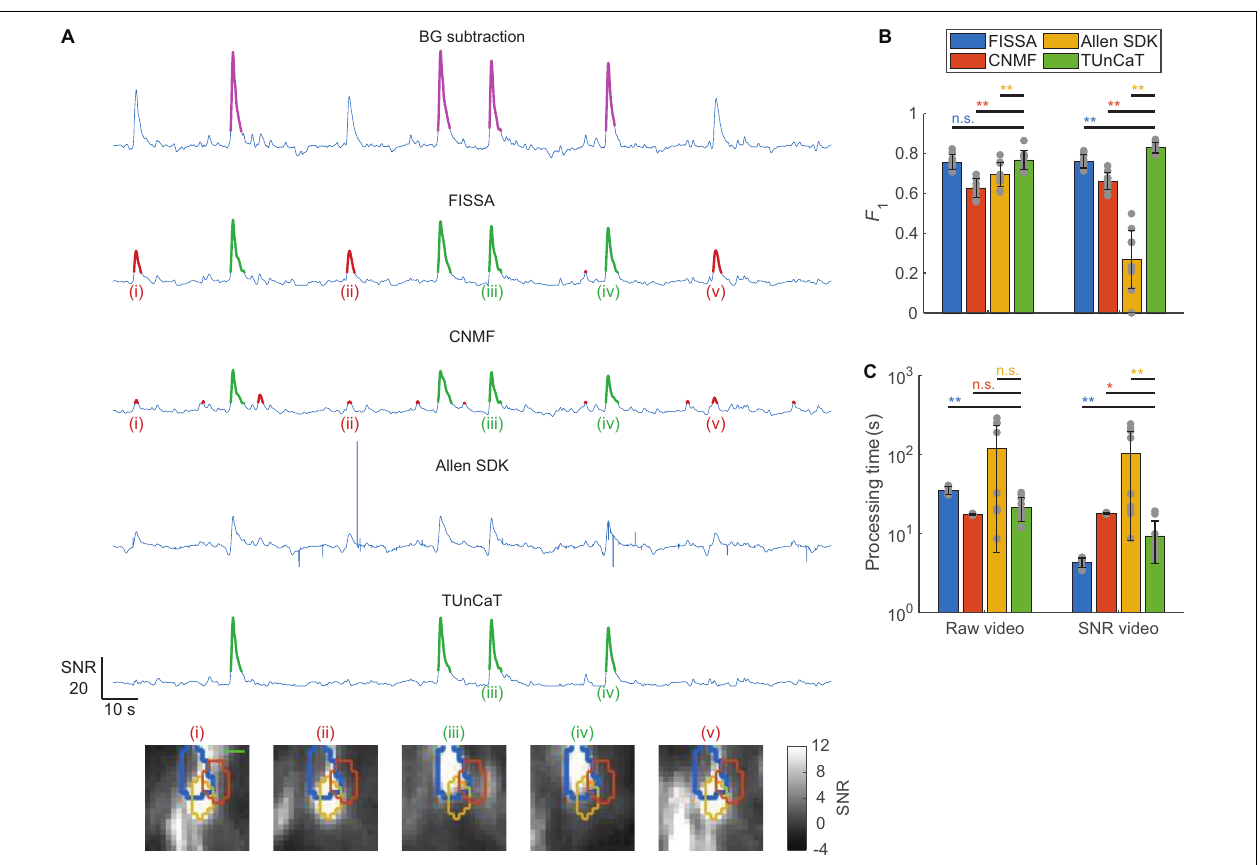
FIGURE 5 | Temporal unmixing of calcium traces (TUnCaT) was more accurate than peer algorithms when processing experimental one-photon videos. (A) TUnCaT can remove false transients caused by neighboring neurons. The first trace is the background-subtracted trace of the SNR video of an example neuron representing the trace before unmixing, and the magenta transients show the manually determined ground truth transients. The four remaining traces are the unmixed traces of that neuron from four different methods (FISSA, CNMF, the Allen SDK, and TUnCaT). The labels (i)–(v) indicate example transients correctly (green) or incorrectly (red) detected by at least one unmixing algorithm. Each image below the traces is the corresponding SNR image at the peak of each transient. The thick blue contour in each image shows the boundary of the neuron of interest, and the orange and yellow contours show the boundary of two different neighboring neurons (scale bar: 10 µ m). (B) The F 1 scores of TUnCaT during 9-round cross-validation were superior to that of the other methods both when processing raw videos and when processing SNR videos (** p < 0.005, n.s. - not significant, two-sided Wilcoxon signed-rank test, n = 9 videos; error bars are standard deviations). The gray dots represent scores for the test data on each round of cross-validation. (C) The processing time of TUnCaT was comparable to or faster than the other methods both when processing raw videos and when processing SNR videos (* p < 0.05, ** p < 0.005, n.s. - not significant, two-sided Wilcoxon signed-rank test, n = 9 videos; error bars are standard deviations). The gray dots represent the processing times for the test data on each round of